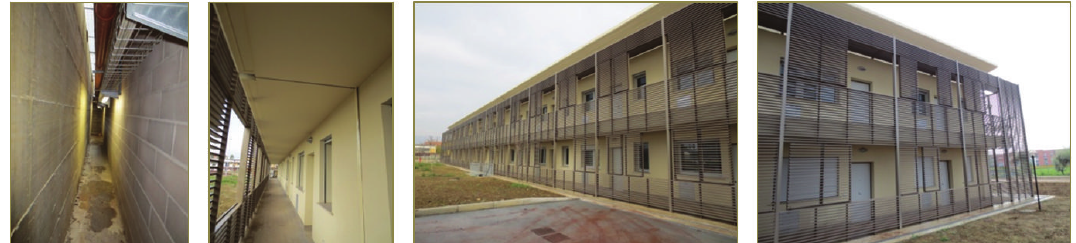
Figure 18: Images of a wing of the perimeter interspace between the retaining wall of the basement and the building, the thermal expansion joint between B2 and B3 blocks, and the main fac¸ades of B1–B3 and B4